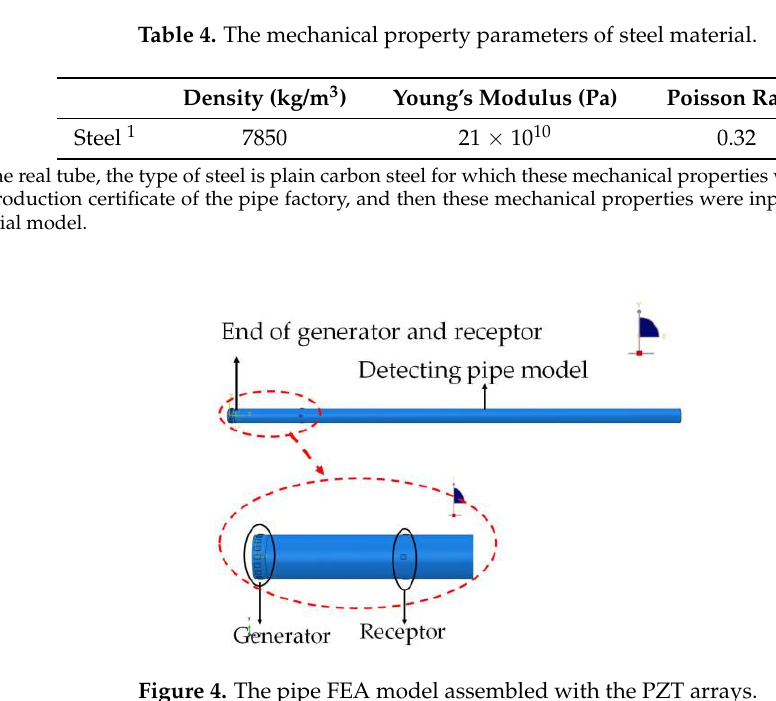
Figure 4. The pipe FEA model assembled with the PZT arrays.